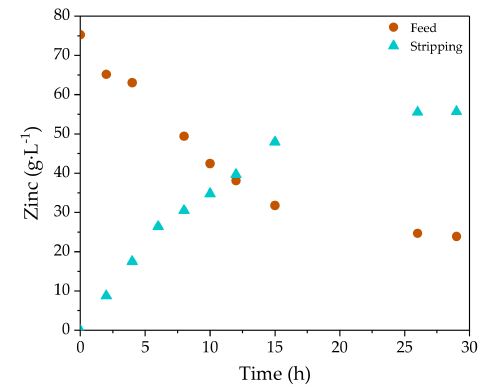
Figure 2. Zinc concentration evolution with time in the feed and stripping phases using NDSX technology in a representative pilot scale test (EXP III).